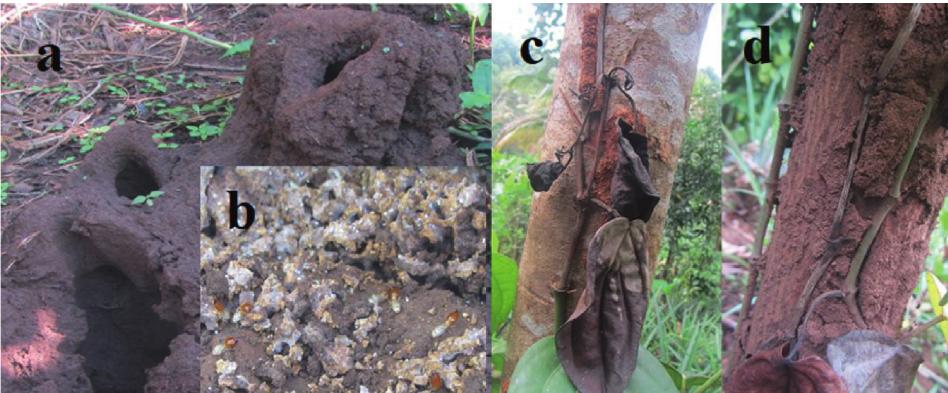
Figure 6: Termites mound in a garden (a), termites from the mound (b), and soil plastered due to termites foraging on peppers and support trees stems (c and